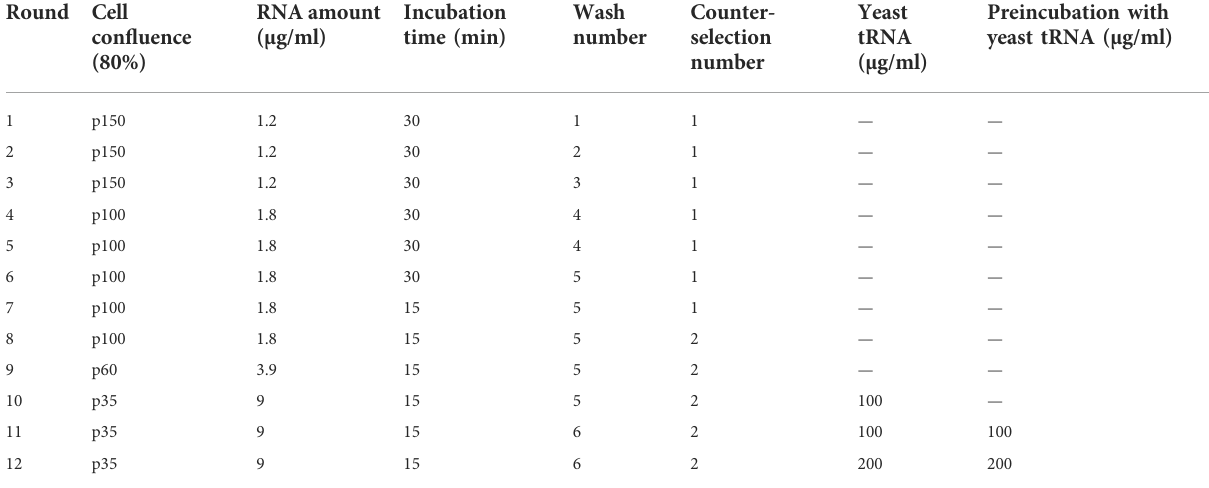
TABLE 1 Hypoxic cell-SELEX